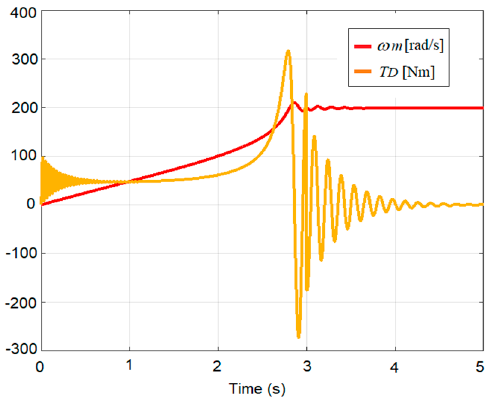
Figure 2. Time courses of the IM model torque and speed at motor starting when supplied by the current vector.